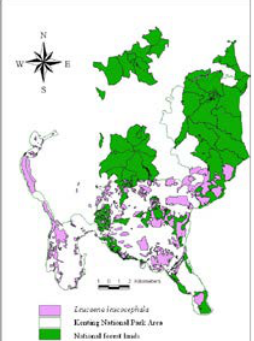
Fig. 3. The distribution of Leucaena leucocephala in Hengchun